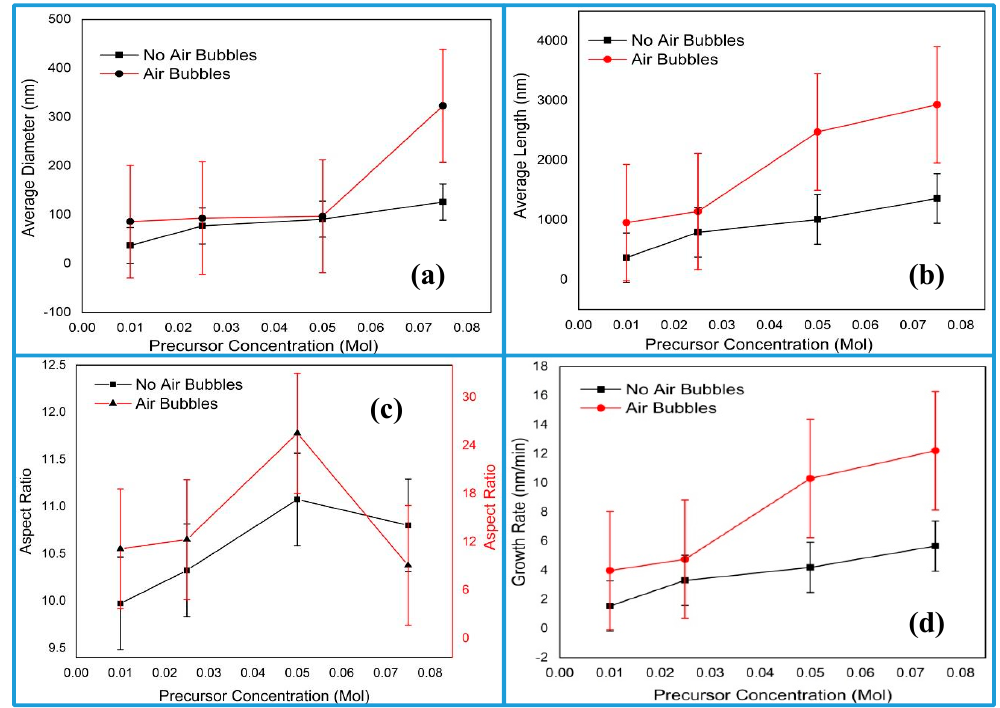
Figure 3. Effect of different precursor concentrations on ZnO nanorods grown using conventional and modified methods: ( a ) average diameter, ( b ) average length, ( c ) aspect ratio and ( d ) growth rate.